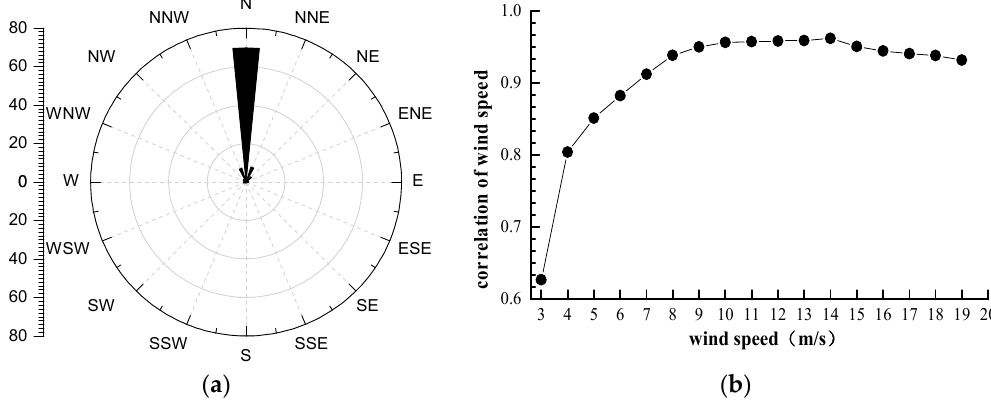
Figure 8. Statistical curve of WSC coefficient under different wind speed segment; ( a ) Wind rose; ( b ) Statistical curve of WSC coefficient under different wind speed segment.